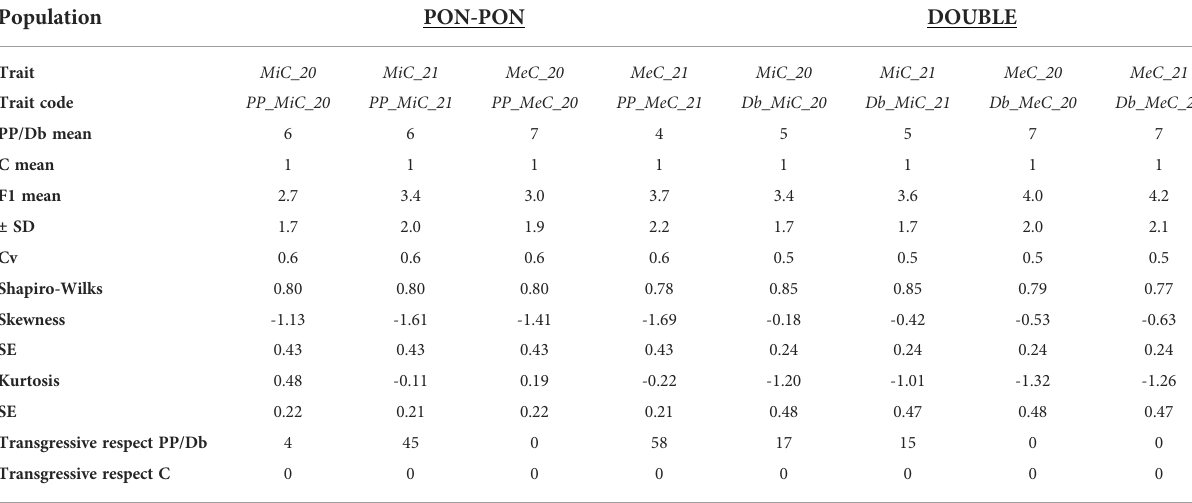
TABLE 2 List of the traits analyzed and their code, means, standard deviations (SD), overall statistics, coef fi cients of variation (cv), and transgressive genotypes. Population PON-PON Trait Trait